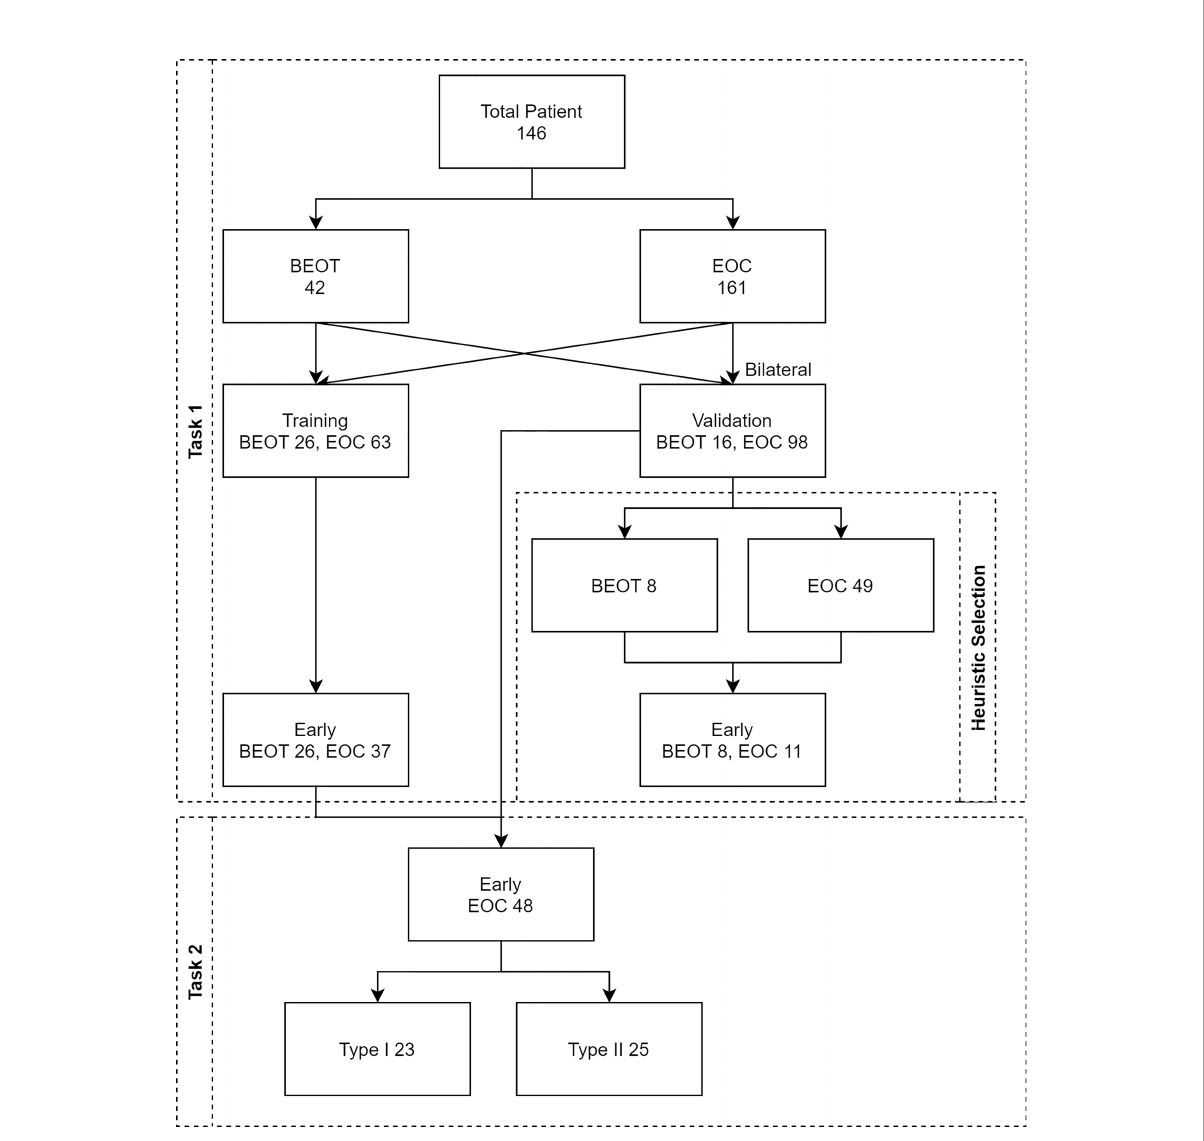
FIGURE 2 Flow diagram illustrating the two classi fi cation tasks. Task 1 was established for distinguishing BEOT from EOC, and task 2 was established from early-stage type I from II EOC. A total of 146 patients with 203 epithelial ovarian tumors, including 34 patients with 46 BEOT and 112 patients with 161